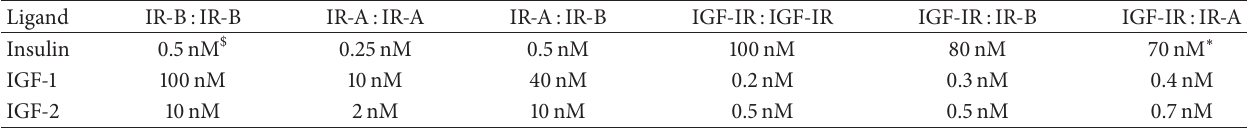
Table 3: Affinities of insulin, IGF-1, and IGF-2 for homodimers and heterodimers of isoform A (IR-A) and isoform B (IR-B) of the insulin receptor and type I IGF receptor